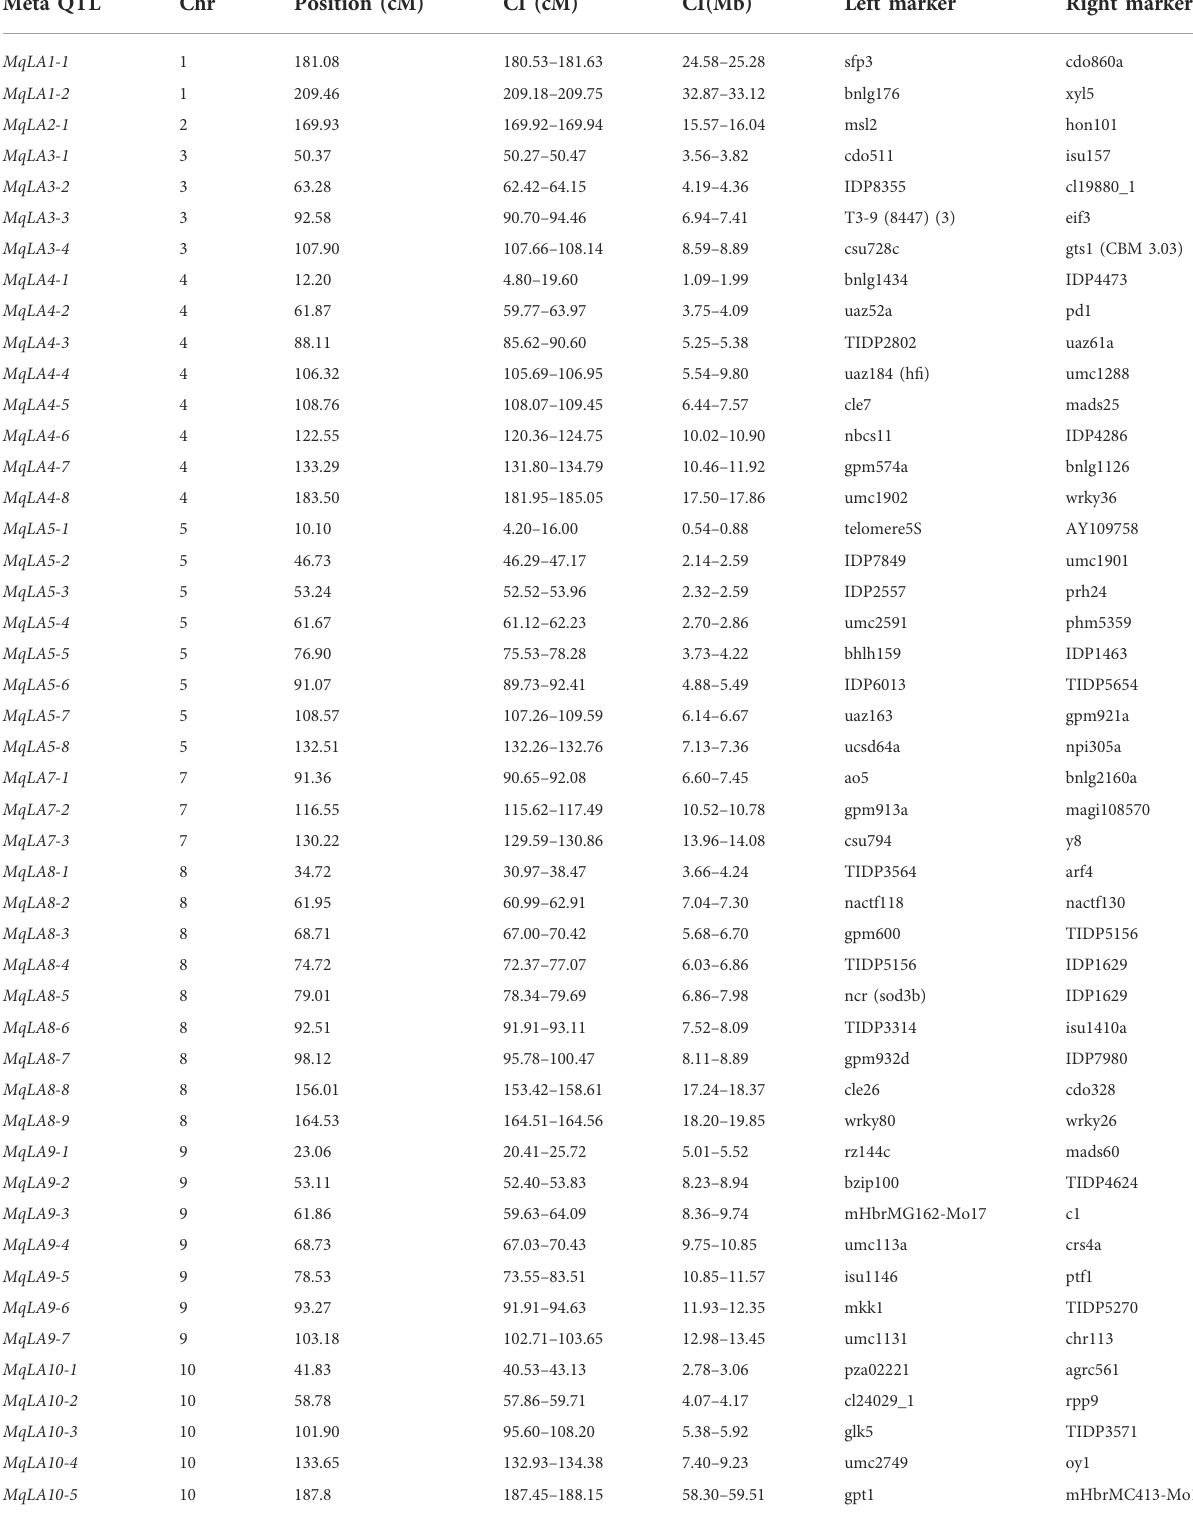
TABLE 2 List of meta-QTLs and accompanying details for leaf angle-related traits in